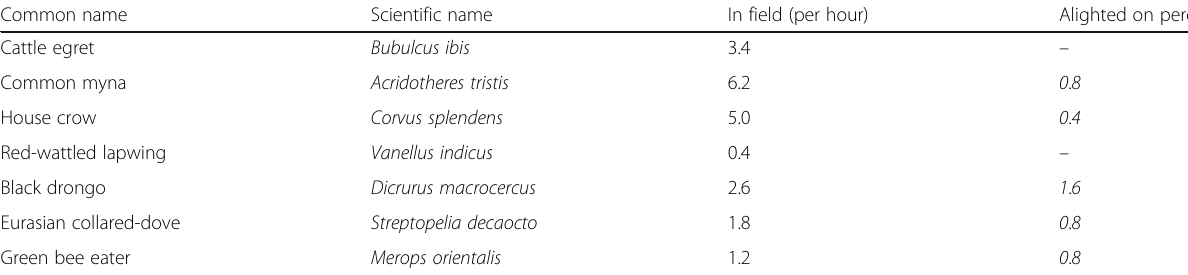
Table 5 Record of insectivorous birds and their activity